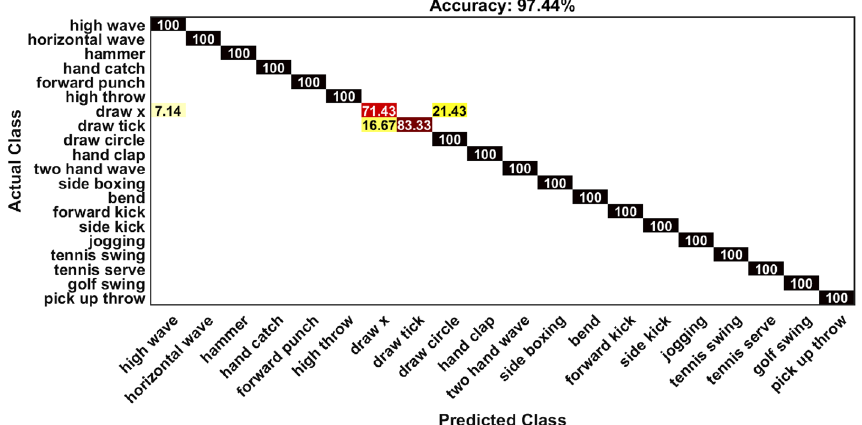
Fig. 9 Confusion matrix obtained for the